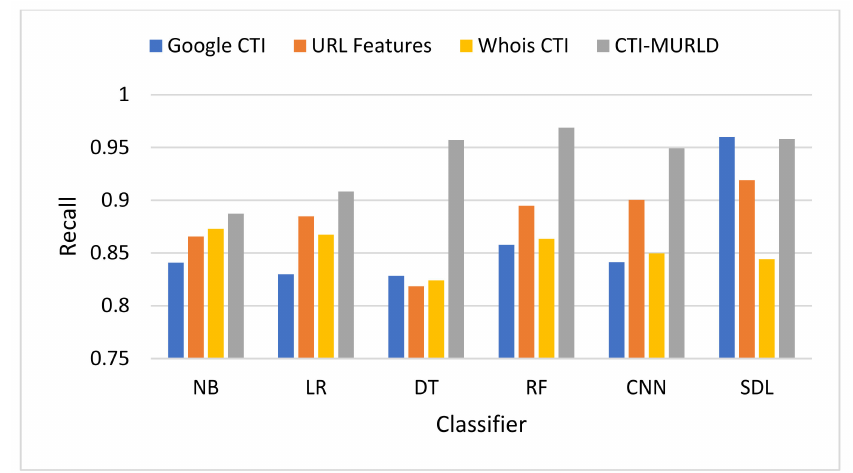
Figure 8. Comparison in terms of the recall (True Positive Rate).